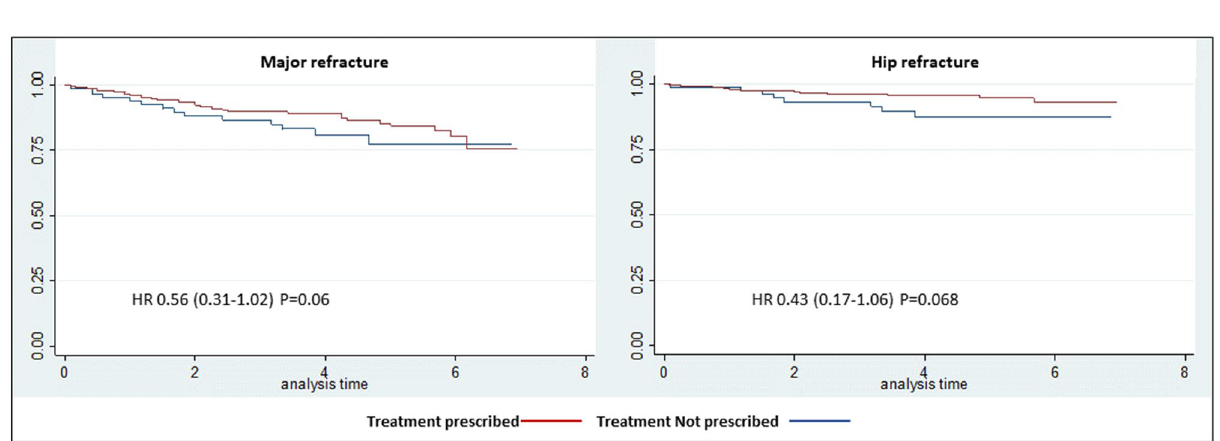
Figure 4. Kaplan–Meier estimates for refracture over 7 years of